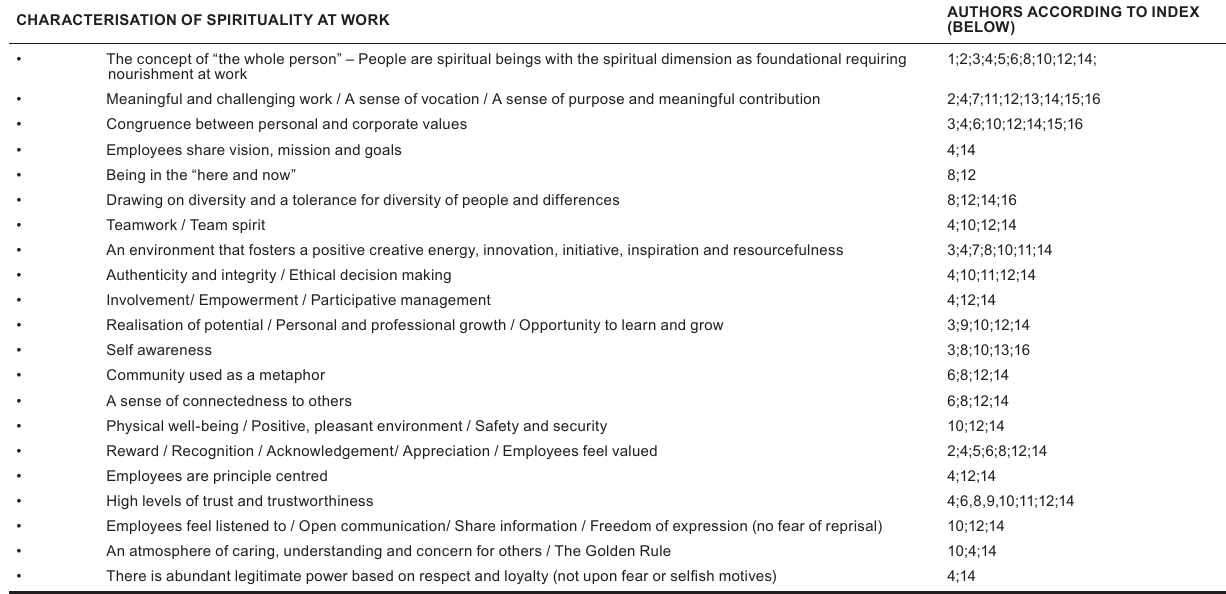
TABLE 4 Viewpoints on what characterises apirituality at